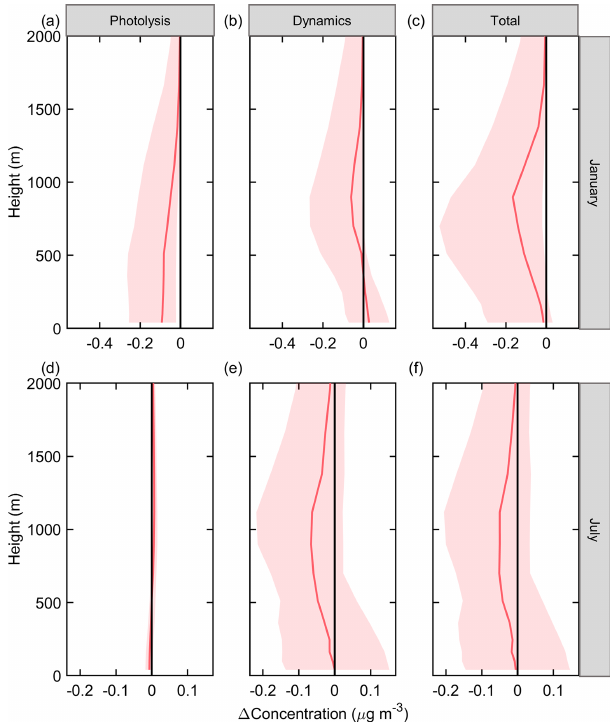
Figure 4. Vertical profile of sulfate concentration change to ADEs in the JJJ region at noontime in January (a, b, c) and July (d, e, f) .